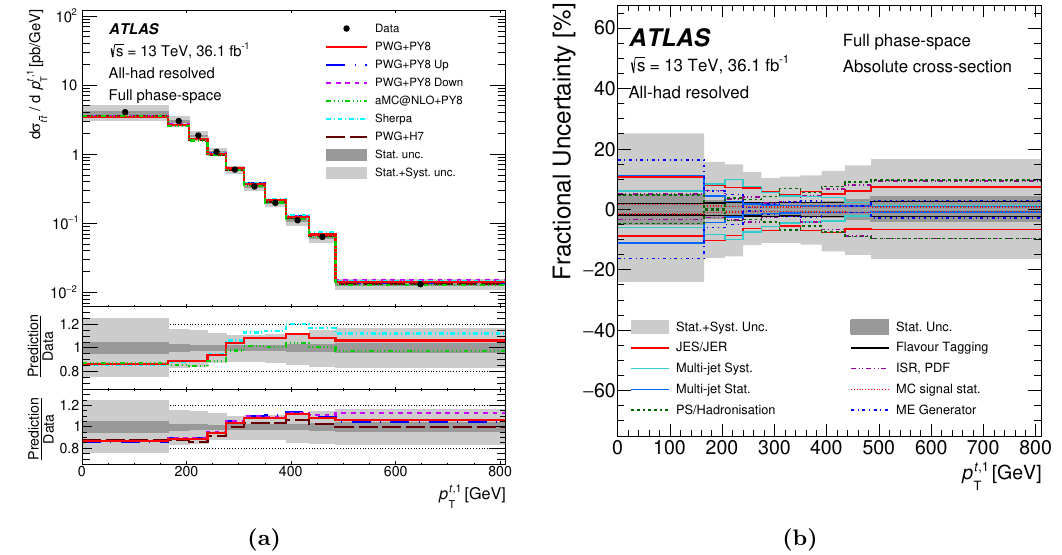
Figure 19 . Single-differential absolute cross-section measurements, unfolded at parton level (a), as a function of the leading top-quark transverse momentum. The unfolded data are compared with theoretical predictions. In the top panel, the unfolded data are shown as black points, while lines indicate the predictions from several MC programs. Uncertainties are shown by the shaded bands. Data points are placed at the centre of each bin. The lower two panels show the ratio of the MC predictions to the unfolded data. Fractional uncertainties for the absolute single-differential distri- butions unfolded at parton level (b) as a function of the leading top-quark transverse momentum. The bands represent the uncertainties in the unfolded data. Lines indicate the breakdown of the major components of the